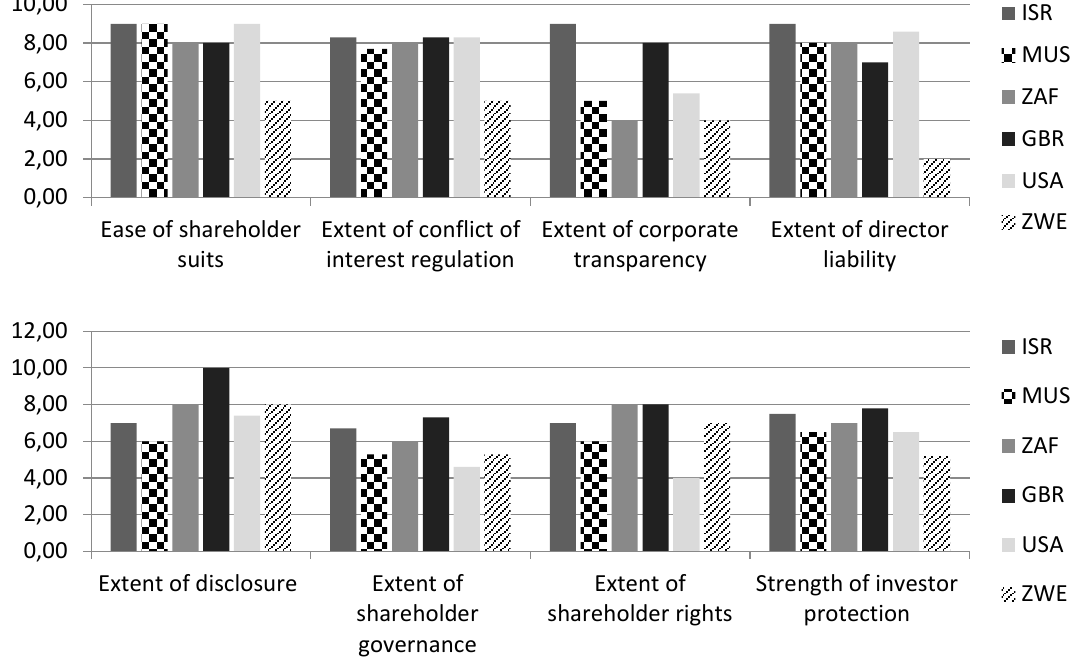
Figure 1. Investor Protection Indices for selected countries as of